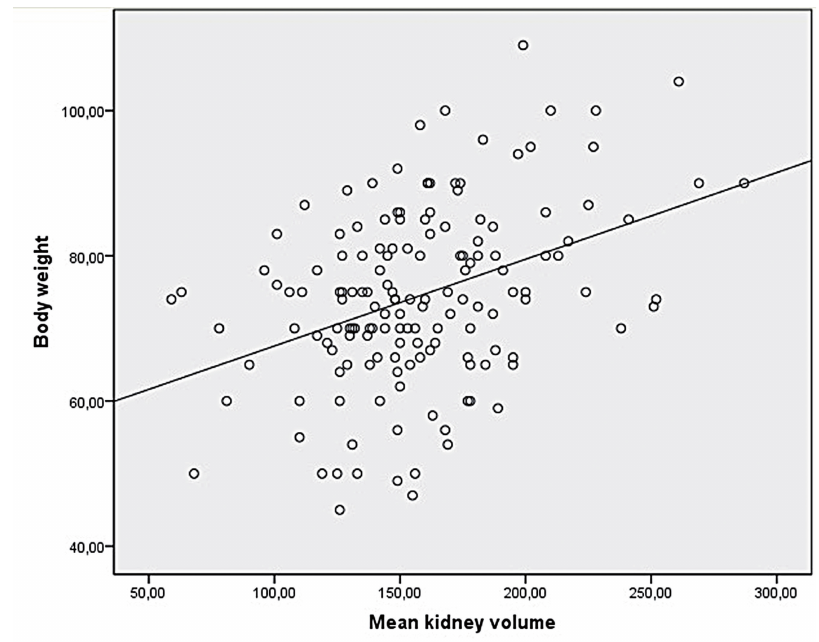
Figure 4 - Relation between mean kidney volume (cm 3 ) and body weight (cm).